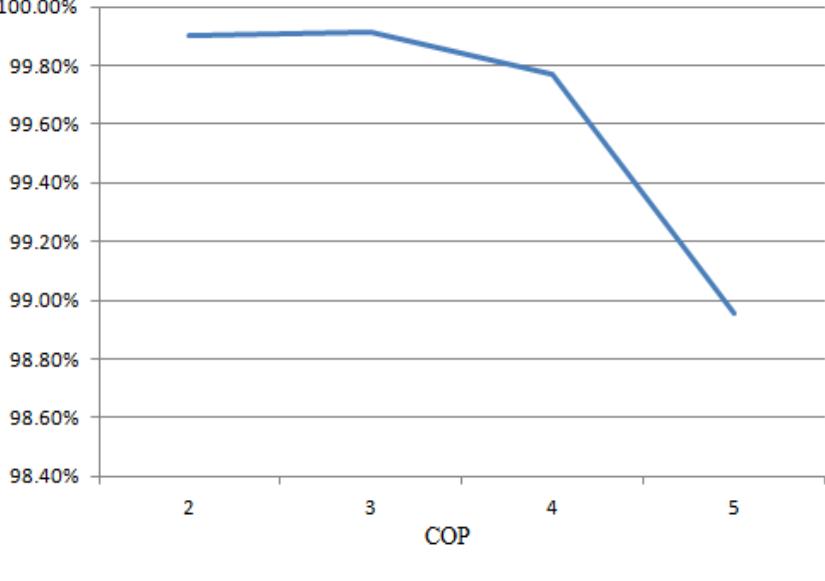
Figure 6. Energy Conservation from More Wind Power Integration.